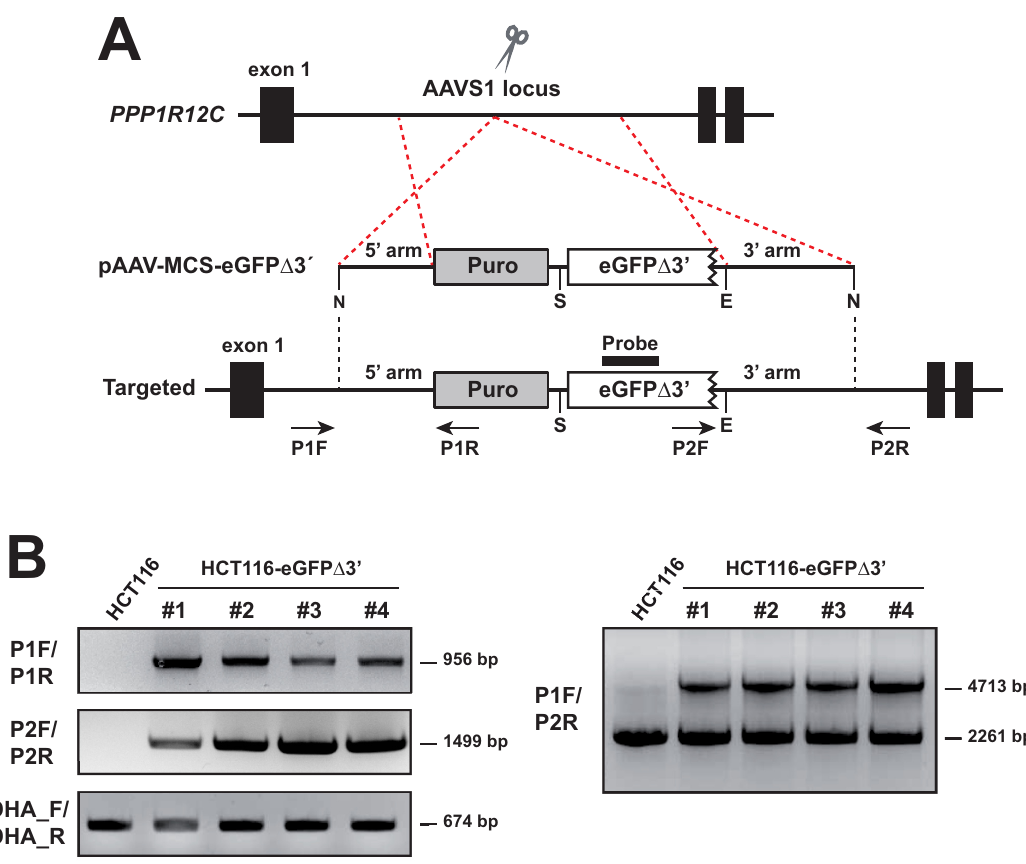
Fig 1. Generation of the HCT116-eGFP Δ 3’ reporter cell line. (A) Schematic illustration of AAVS1 gene targeting with pAAV-MCS- eGFP Δ 3’ plasmid. Puro, puromycin-polyA promotorless cassette; N, NotI; S, SalI; E, EcoRI. Exons are indicated by black boxes. (B) Representative PCR analysis for site-specific integration with the primer pairs P1F/P1R (5’ arm), P2F/P2R (3’ arm), and hSDHA_F/ hSDHA_R (loading control). (C) Representative PCR analysis for the homo/heterozygosity targeting of the AAVS1 locus with the primer pair P1F/P2R. Positions of the primers used for screening are designated by arrows in panel A. eGFP Δ 3’ gene copy number and rule out integration at other off-target sites. Pairs of primers